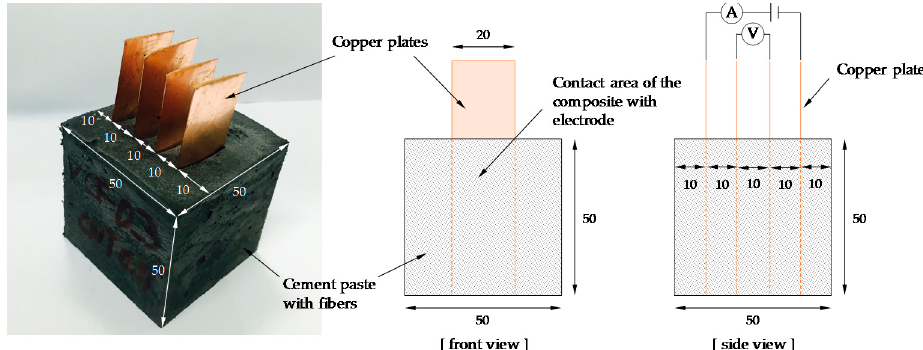
Figure 2. Test specimens for resistance measurement (unit: mm).